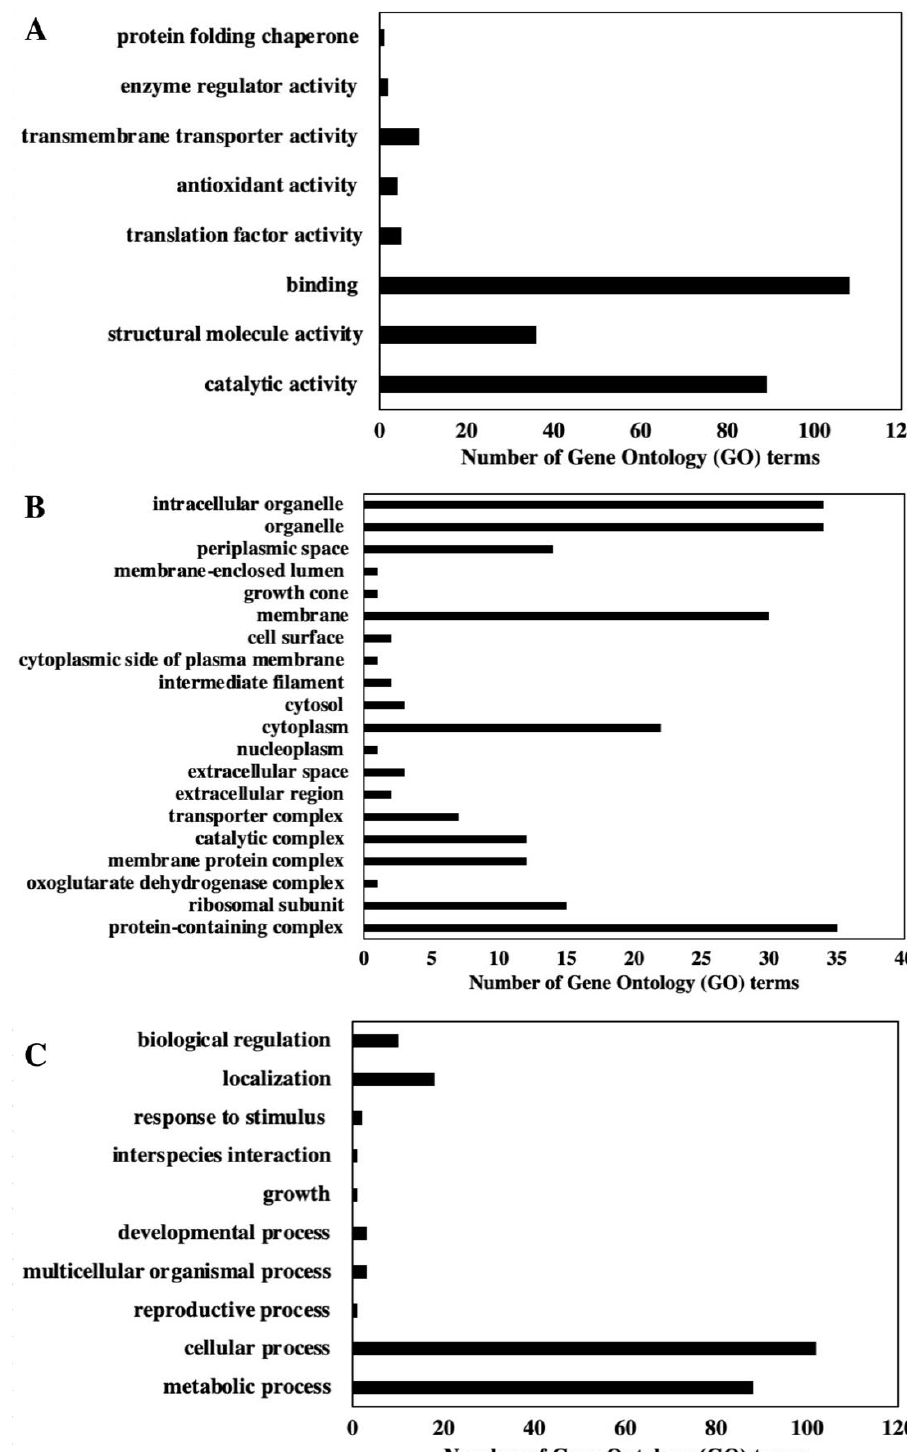
Figure 1. Gene Ontology (GO) terms for the molecular function, cellular components, and biological process based on proteins identified using the NCBInr database search: ( A ) Molecular function GO term distribution highlights binding, structural molecule activity, and catalytic activity as top three annotated GO terms. ( B ) Cellular component GO terms include organelle, intracellular organelle, and protein containing as top three GO term hits. ( C ) Biological process GO terms include cellular process, metabolic process, and localization as the three most associated GO terms with the proteins identified.